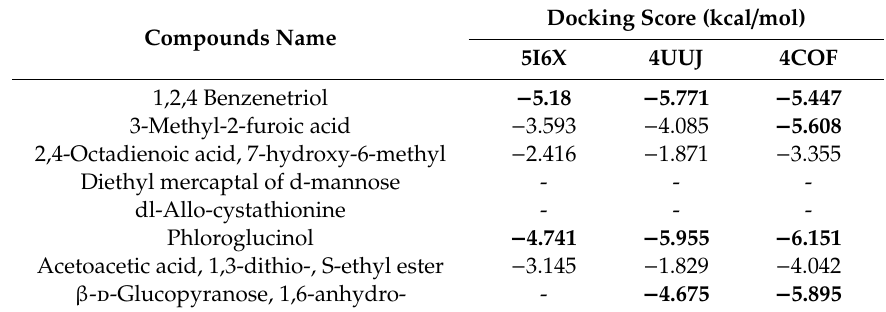
Table 5. Docking score of the selected compounds in MECVL against the human serotonin receptor (pdb: 5I6X), potassium channel receptor (pdb: 4UUJ), and human gabaa receptor (pdb: 4COF) for antidepressant, anxiolytic, and sedative activity,